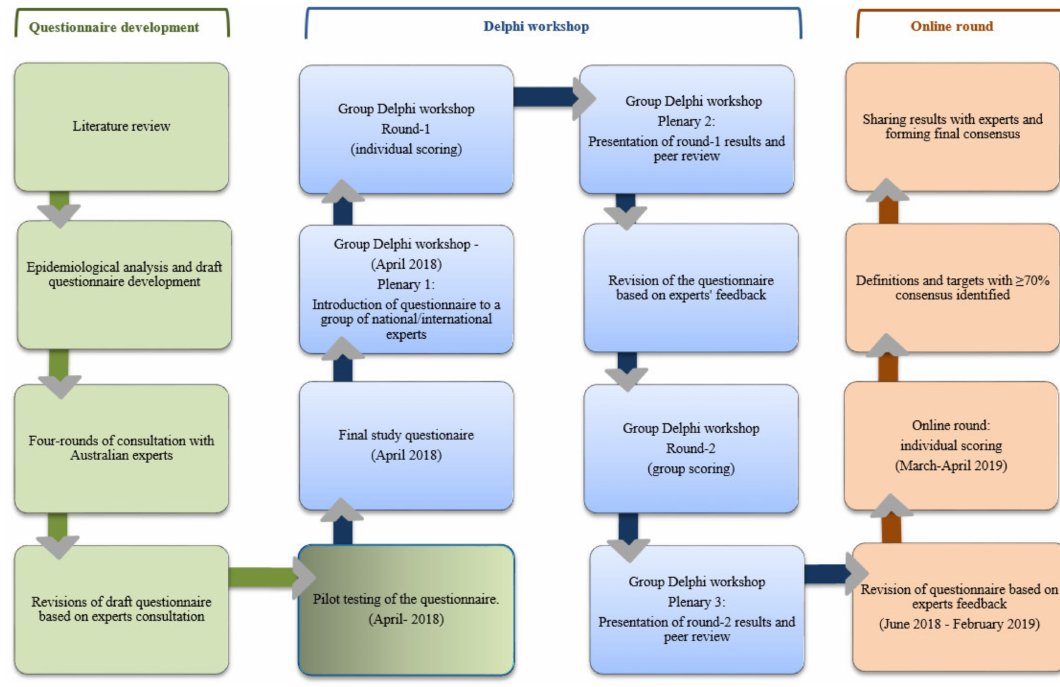
Figure 1. Flowchart of the process for development of